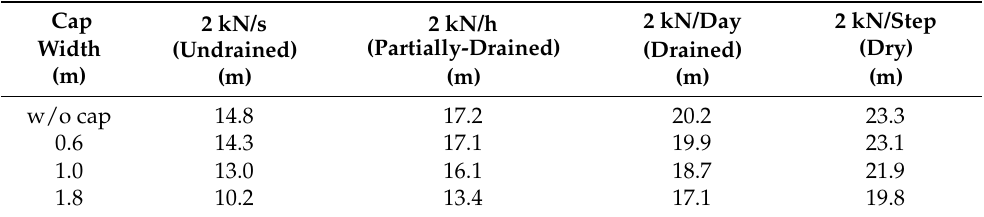
Figure 5. Effect of pile cap width on lateral displacement of pile cap: ( a ) undrained (loading rate = 2 kN/s); ( b ) partially drained (loading rate = 2 kN/h); ( c ) drained (loading rate = 2 kN/day); and ( d ) dry soil (loading rate = 2 kN/step). Table 4. Effect of cap width on displacement of pile cap under various loading conditions and in dry